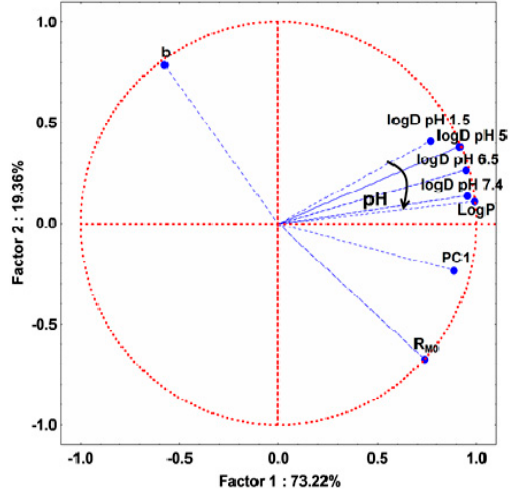
Figure 4. Loadings (circle correlation) for the experimental lipophilicity indices (R M0 , PC1, b) and computed (logD and logP—calculated by the equally weighted calculation algorithm combining the three methods described in the Experimental Section) lipophilicity indices for all the studied compounds.